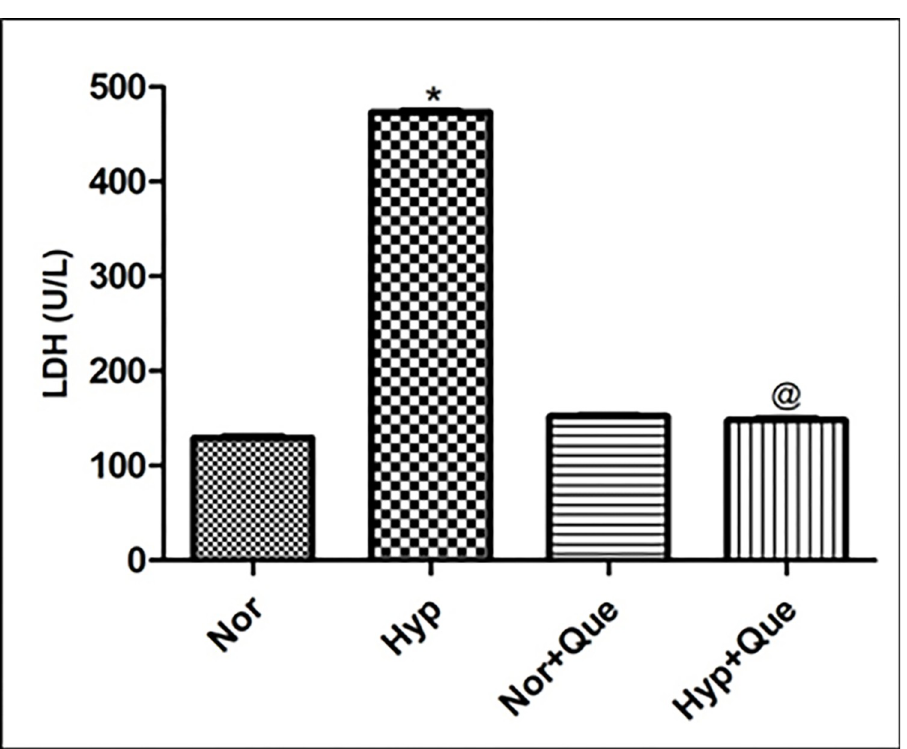
Fig 10. Effect of quercetin on lactate dehydrogenase (LDH) (renal tissue injury) in rats supplemented with 50mg/ kg BW quercetin prior to hypoxia exposure of 12h at 7,620m, 25 ± 2˚Values are mean ± SD (n = 6). � p < 0.001 Norm v/s Hypo 12h; @ p < 0.001 Hypo v/s Hypo+ Que. Norm-Normoxia control, Hypo–Hypoxia exposure of (12h), Que- Quercetin (50mg/kg BW). Effect of 50mg/kg BW dose of quercetin on protein expression of HIF-1 α and VEGF. Hypobaric hypoxia exposure appreciably stabilized the HIF-1 α protein expression in kidneys of rats as compared to normoxia control. One of the genes regulated by HIF-1 α is VEGF, which was found to be upregulated under hypobaric hypoxia exposure compared to normoxia control. 50mg/kg BW quercetin administration stabilized the HIF-1 α protein expression and